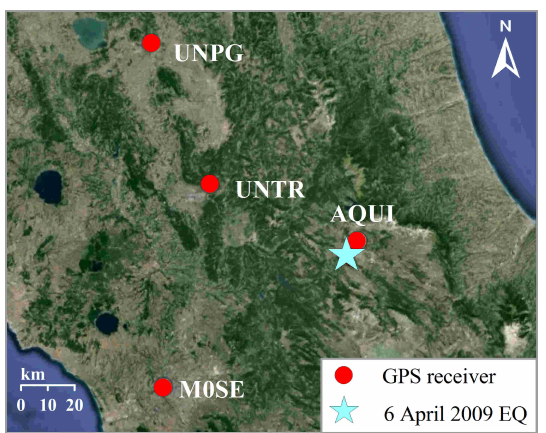
Figure 1. Four GPS receivers in central Italy whose data were anal- ysed by Nenovski et al. (2015).